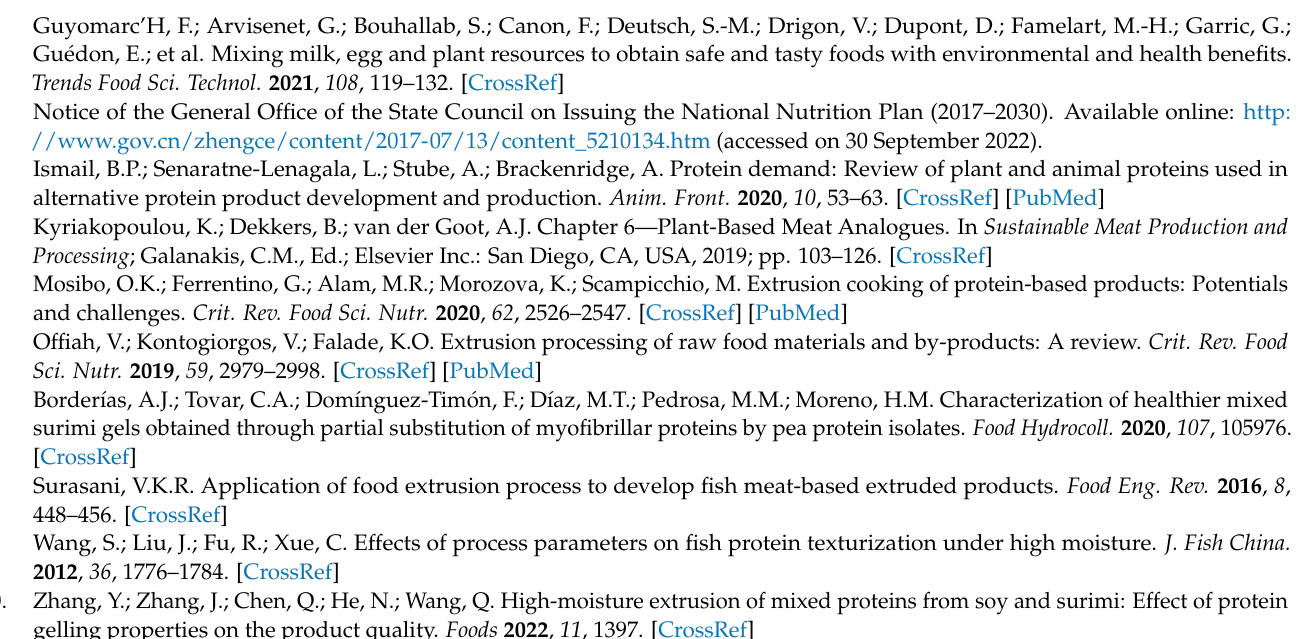
Table S2: Power law equation fitting results of steady shear flow curves of the raw materials with different surimi to soybean flour ratio; Figure S1: Fourier self-deconvoluted curve-fitted spectra (A-G) for raw materials and extrudates with different surimi to soybean flour ratio. A-raw frozen surimi; B-raw soybean flour; C-G extrudates with different addition percentages of surimi at 0:10, 1:9, 2:8, 3:7, 4:6,